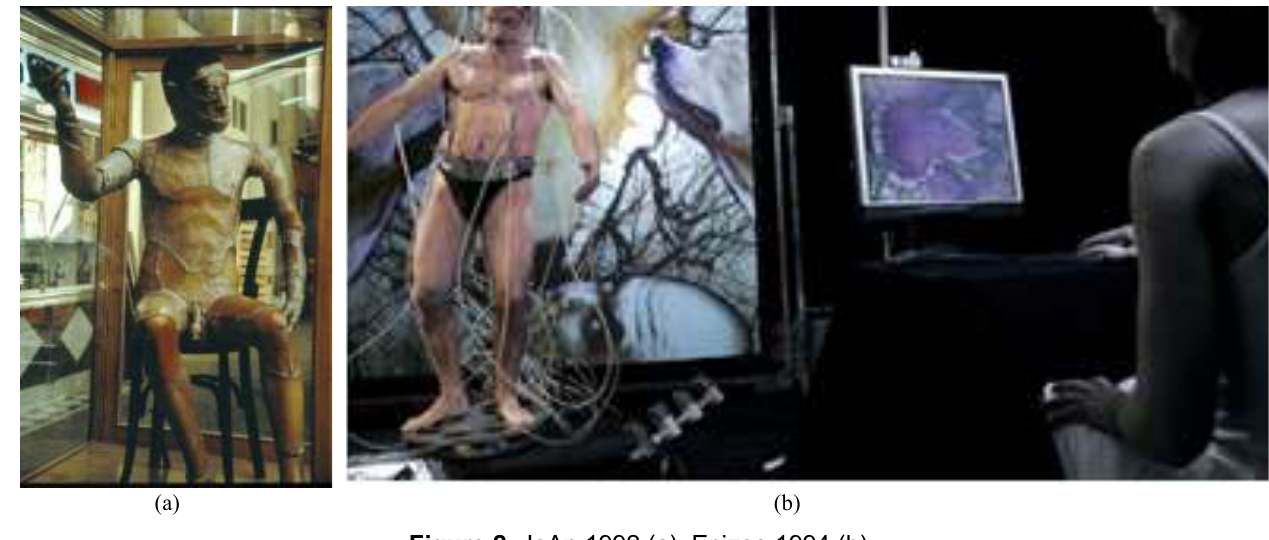
Figure 2 . JoAn 1992 (a), Epizoo 1994